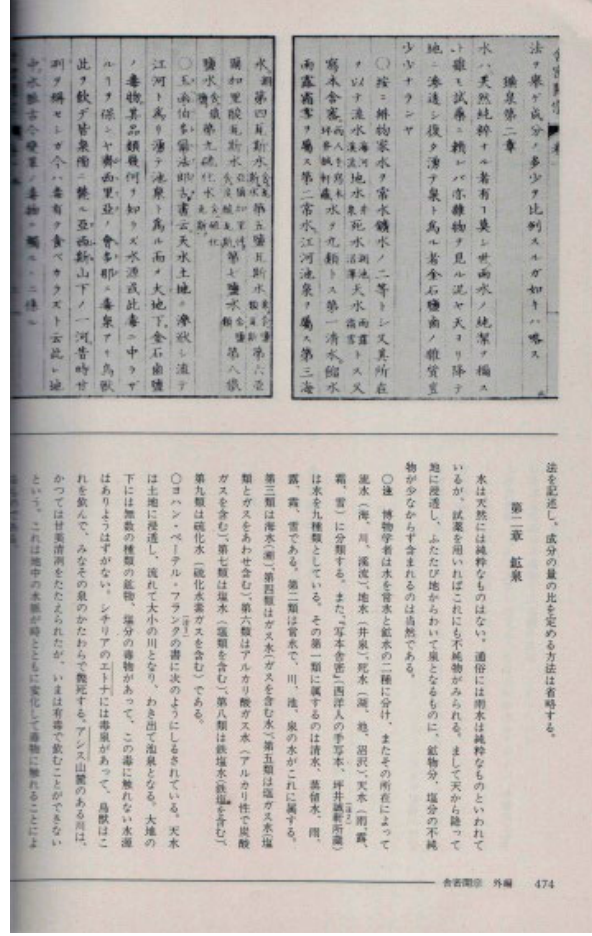
Figure 5. Upper part: Seimi Kaiso external book vol. 1, ch. 2 on mineral spring. Lower part: Seimi Kaiso Research p. 474. The first lines of the text on water impurities are dealt with in chapter 3 below. Photo: Y.